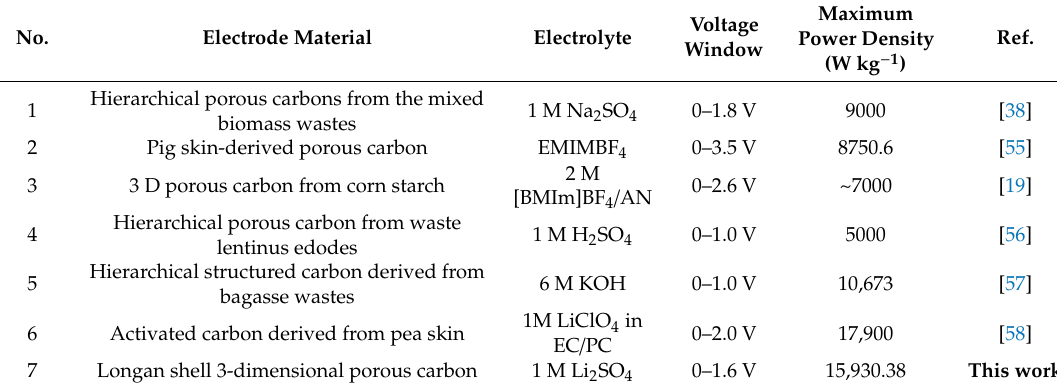
Figure 8. Electrochemical performances of the as-assembled LSPC800-based supercapacitor (SC) device in 1 M Li 2 SO 4 electrolyte: ( a ) CV curves upon different voltage windows at 20 mV s −1 ; ( b ) CV curves at scan rates varying from 5 to 100 mV s −1 ; ( c ) GCD curves at different current densities; ( d ) specific capacitance and coulombic efficiency of the SC device at different current densities; ( e ) the Nyquist plot of the assembled SC device; and ( f ) the Ragone plot of the assembled SC device. Table 3. Comparison of the maximum power density of MAC-800 with other biomass porous carbon electrodes.